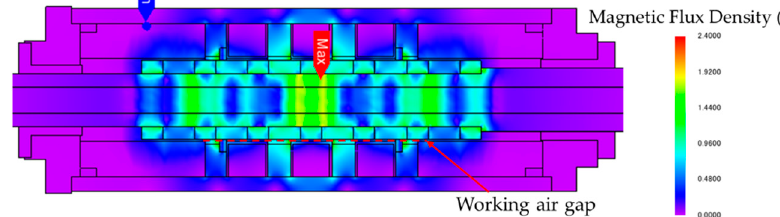
Figure 3. Cloud diagram of magnetic flux intensity.